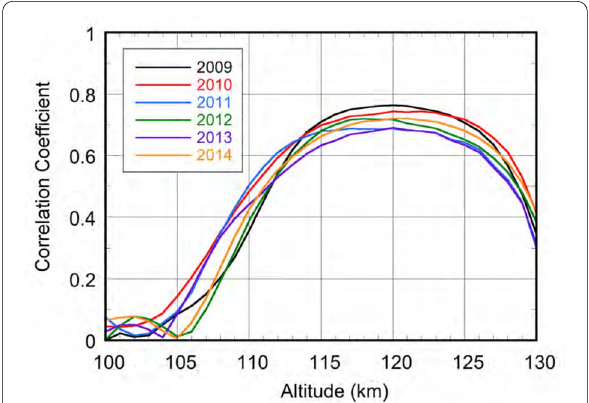
Fig. 5 Correlation coefficients of the daily average foEs and VIC 120 . Correlation coefficients of the daily average foEs and the vertical ion convergence at 120 km altitude are shown for the years of 2009–2014 at Kokubunji in